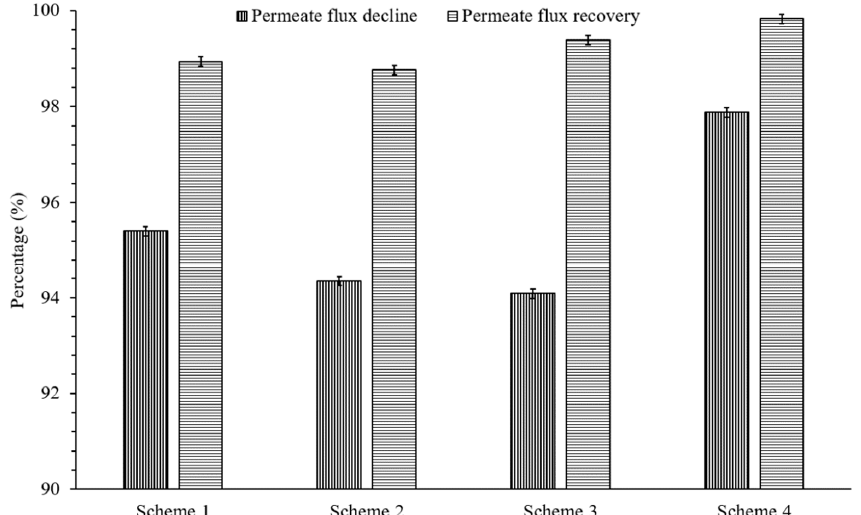
Figure 3. The percentage permeate flux decline and permeate flux recovery after CIP with EDTA (1%), NaOH (0.1%), and HCl (0.2%). Cleaning solutions were introduced from the feed side (50 mL/min flowrate, 25 °C temperature, 1 bar applied pressure, and 1 h contact time for each chemical).